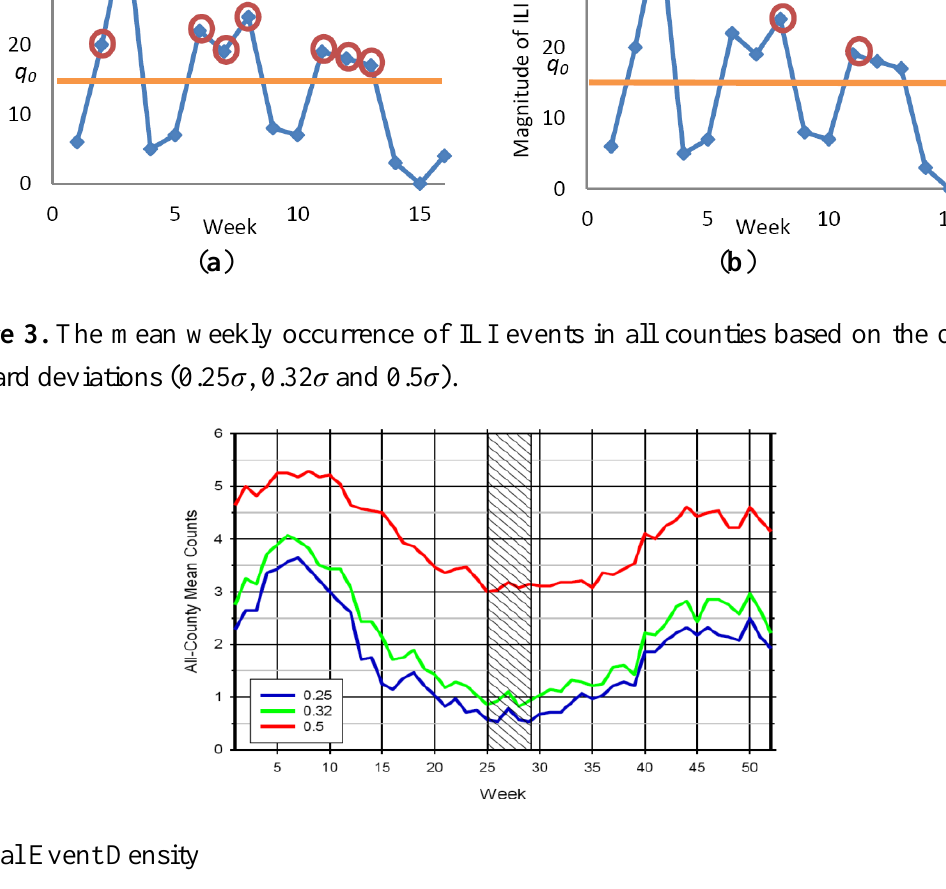
Figure 2. Definitions of magnitudes above the threshold. ( a ) Definition 1. ( b ) Definition 2. The blue curve represents weekly influenza-like illness (ILI) cases; the red circle represents the selected peak; and the orange line represents the threshold ( q